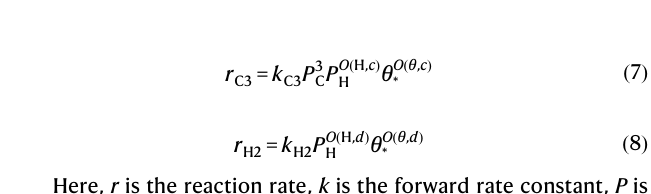
function of carbon partial pressure P C (arb. unit) at the surface. Source data are provided as a Source Data fi